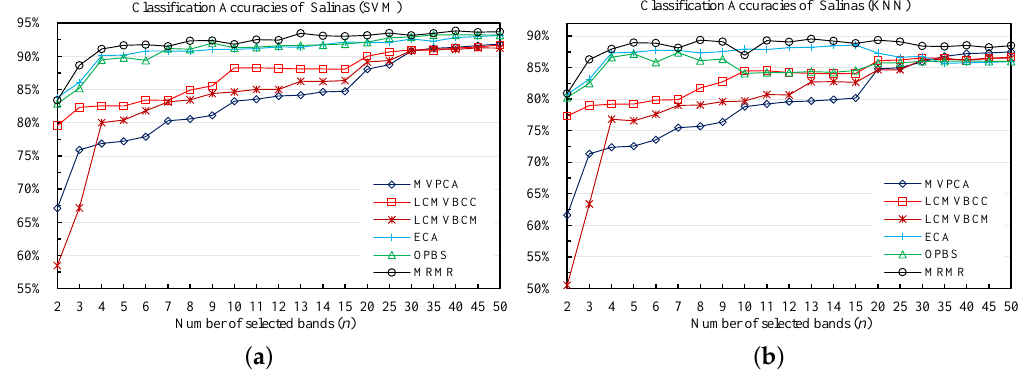
Figure 14. Overall classification accuracies of using the bands selected by different BS methods from the Salinas dataset. ( a ) SVM ( b ) KNN.